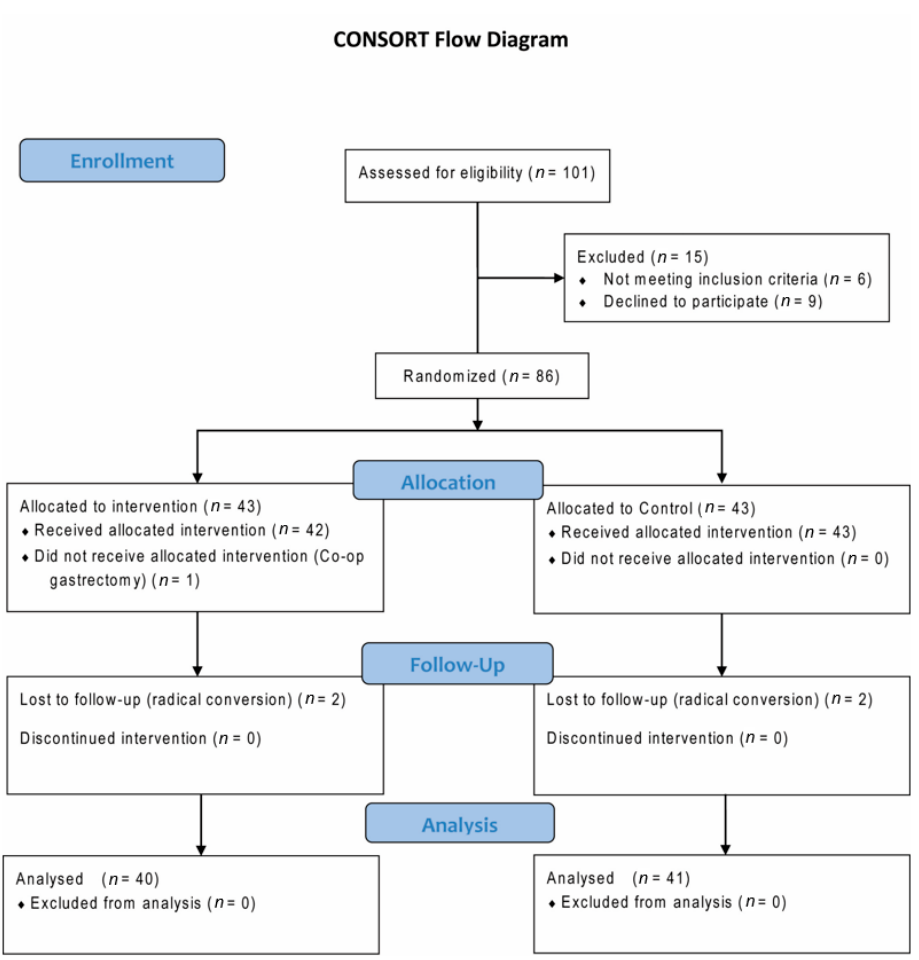
J. Clin. Med. 2021 , 10 , 1636 Figure 1. Consolidated Standards of Reporting Trials (CONSORT) flowchart. Figure 1. Consolidated Standards of Reporting Trials (CONSORT) flowchart.